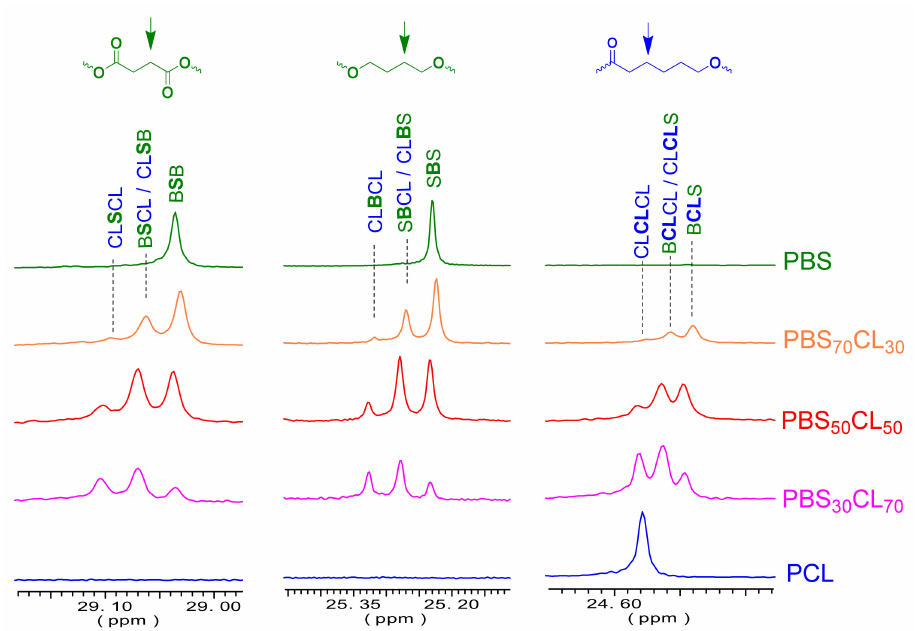
Figure 6. 13 C NMR spectra of PBS, PCL, and PBS x CL y copolyesters in the regions where different carbons split due to sequence distribution effects.